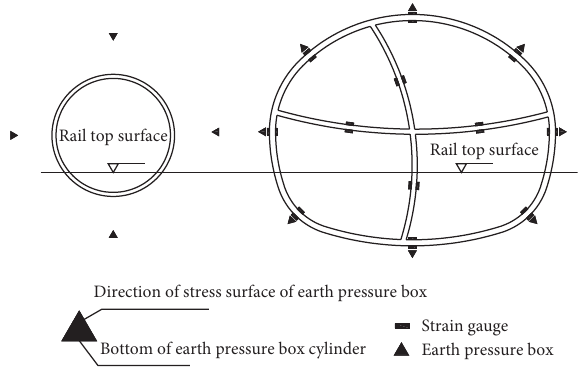
Figure 8: Monitoring section and monitoring point